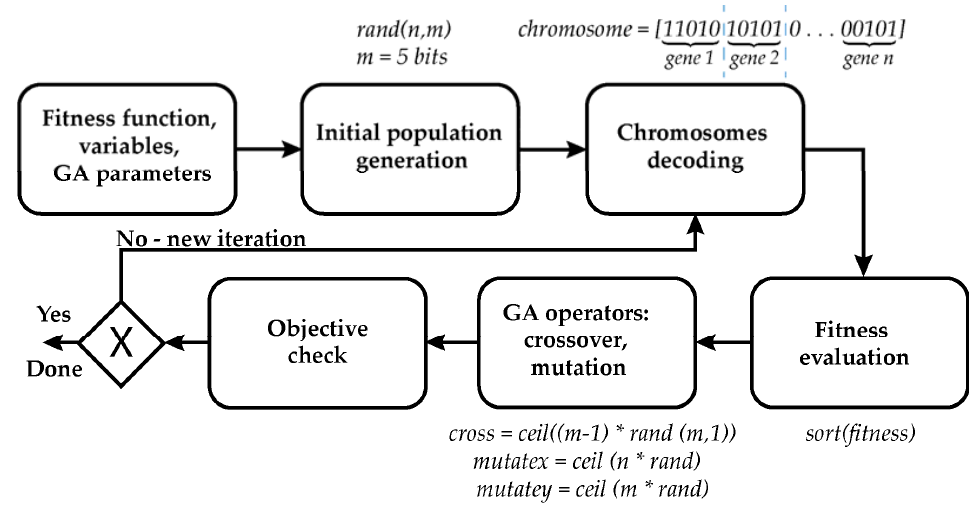
Figure 4. Binary GA general process diagram.